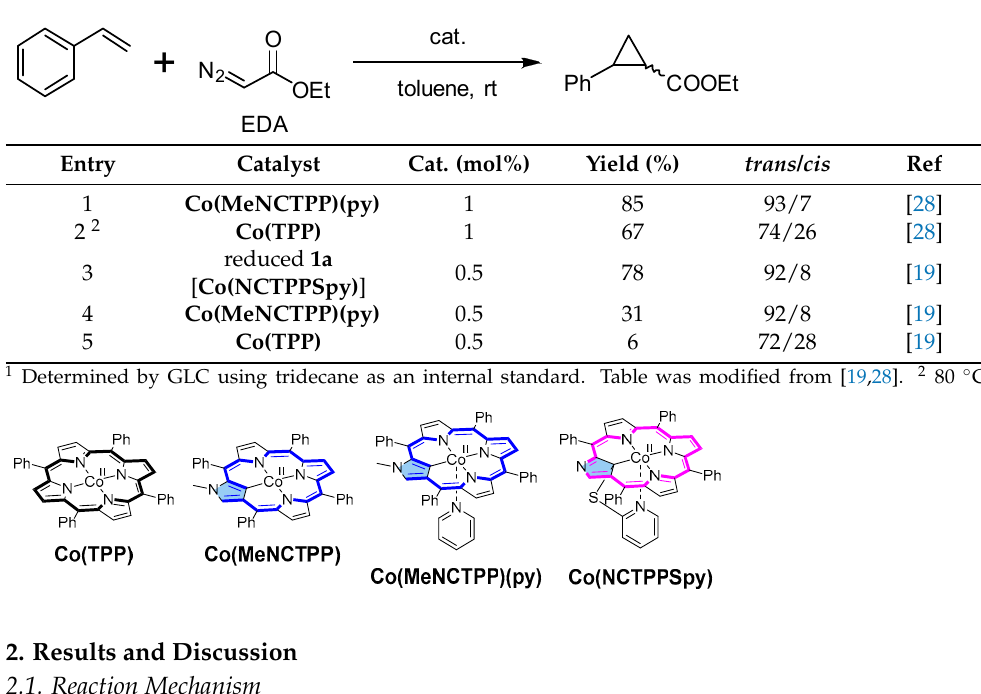
Table 1. Yield and trans / cis selectivity for the cyclopropanation of styrene with EDA 1 .